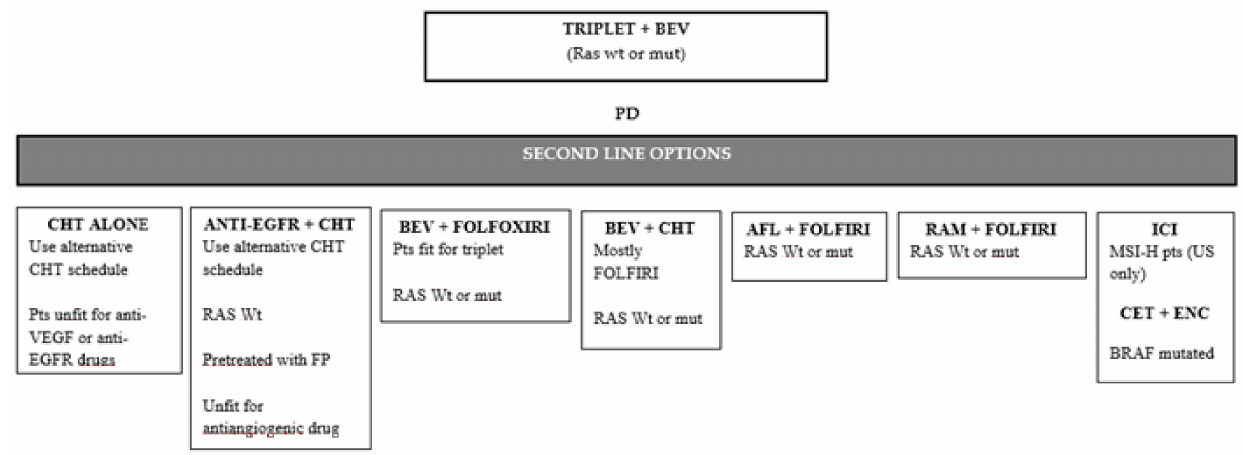
Figure 3. Second-line therapeutic options after disease progression to a triplet + Bevacizumab first line therapy. PD: progres- sion disease; BEV: Bevacizumab; CHT: chemotherapy; wt: wild-type; mut: mutant; IRI: Irinotecan; FP: fluoropyrimidines; AFL: Aflibercept; OXA: Oxaliplatin; RAM: Ramucirumab; FP: fluoropyrimidines; ICI: immune-checkpoint inhibitors; US: United States; CET: Cetuximab; ENC: